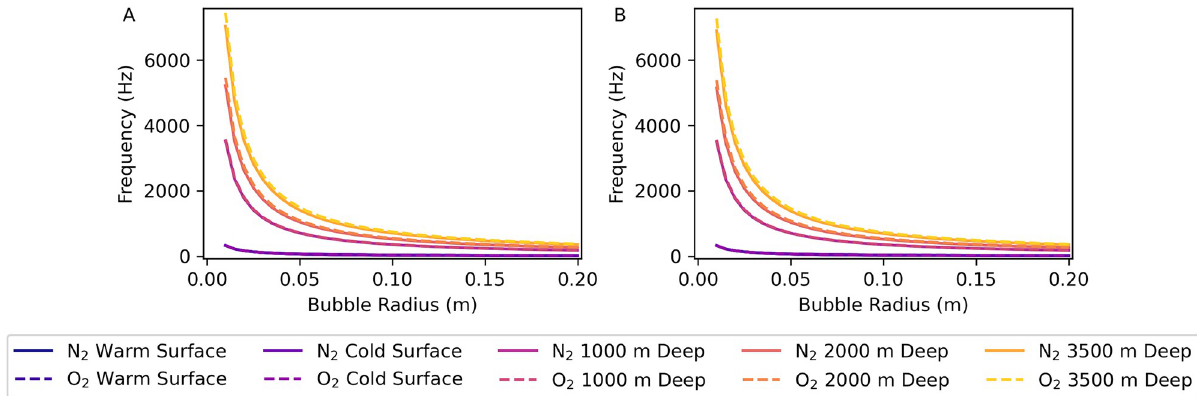
Fig 1. Bubble frequency vs. bubble radius for nitrogen and oxygen bubbles. (A) Undamped bubble oscillation frequency f ffiffiffiffi p = ð 2 p Þ vs. bubble radius. (B) Far field resonant frequency f σ vs. bubble radius. Parameter values for each environment are given in Table 1. See K sections 5.4–5.7 in S3 and S4 Files for the calculations used for this plot. The curves for nitrogen and oxygen bubbles in the warm and cold shallow- water environments all overlap in both subplots A and